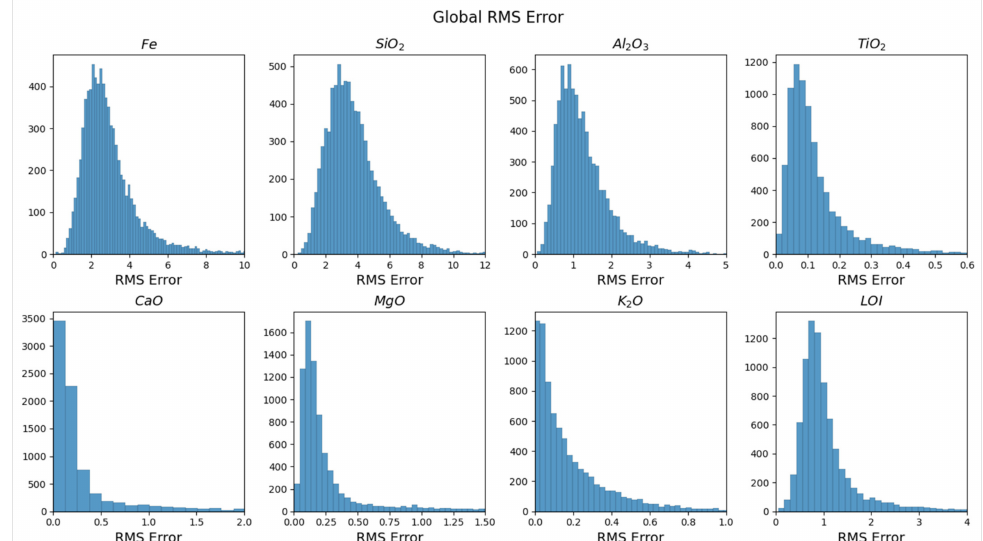
Figure 5. The RMSE (wt.%) distribution of the eight whole-rock geochemistry parameters as calcu- lated from the 6 validation datasets. In this case the RMSE is that reported on a per-drillhole basis so the spread of potential RMSE can be evaluated. While the R 2 scores (Figure 1) for TiO 2 , CaO, MgO and K 2 O were found to generally be smaller than the other four majors the small RMSE and known distribution still indicate a successful